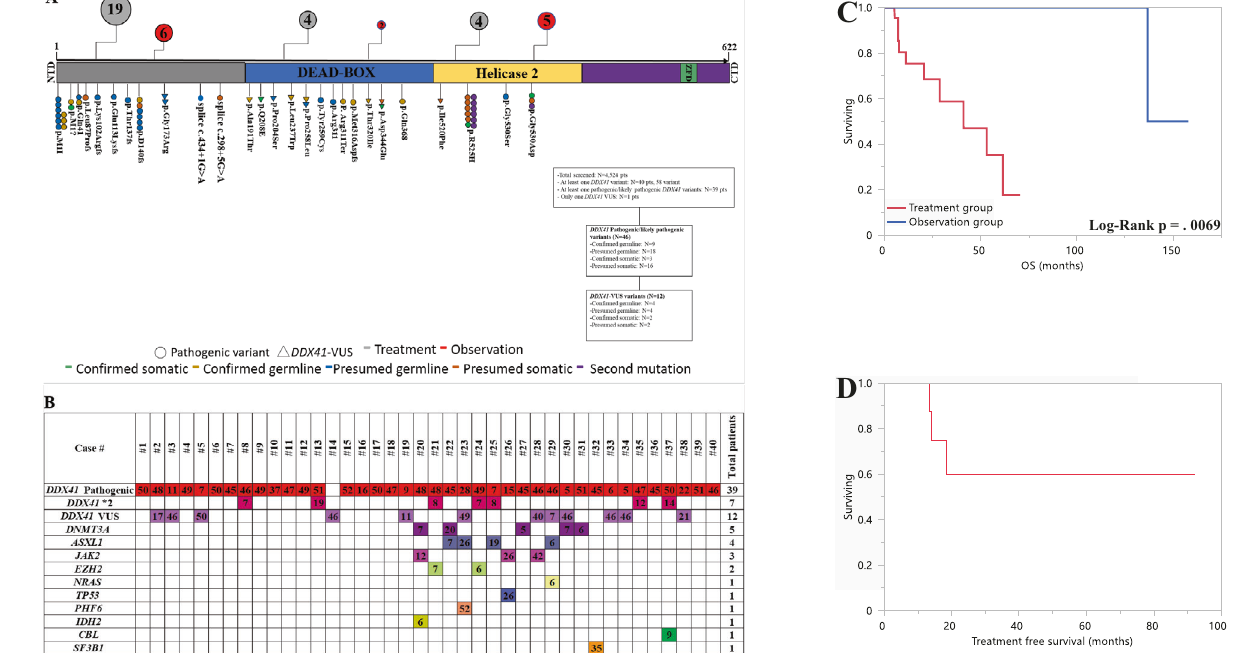
Fig. 1 Observation and treatment in DDX41 mutated myeloid neoplasms. A Distribution of DDX41 variants detected, positioned on the DDX41 protein and its functional domains with representation germline & somatic status and fl owchart of the study. Number of patients in the treatment and observation group in relation to the predominate DDX41 mutation location are represented in the red and grey circles. B Patterns of the co-mutations identi fi ed in the DDX41 cohort and respective VAF value. C Kaplan – Meier survival curve in m DDX41 patients grouped by treatment and observation group. D treatment-free-survival for observation cohort. NTD N-terminal domain, ZFD zinc fi nger domain, CTD C-terminal domain, Pts, patient; *2 Second pathogenic DDX41 mutation.